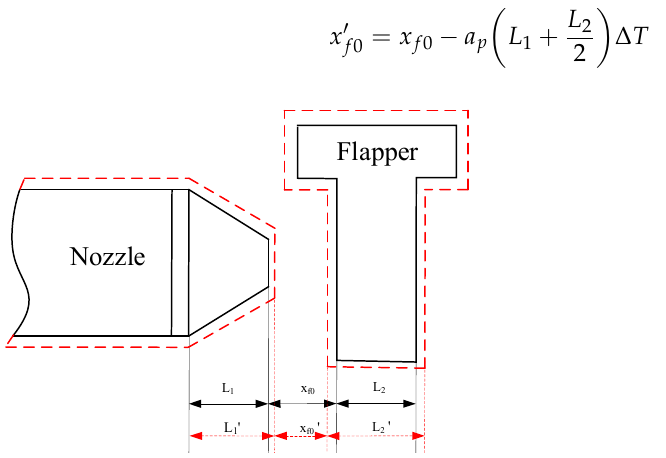
Figure 8. The expansion of the nozzle and flapper. In which, x f 0 is the clearance between the nozzle and flapper, L 1 and L 2 are the flapper thickness and the free end’s length at the initial temperature,